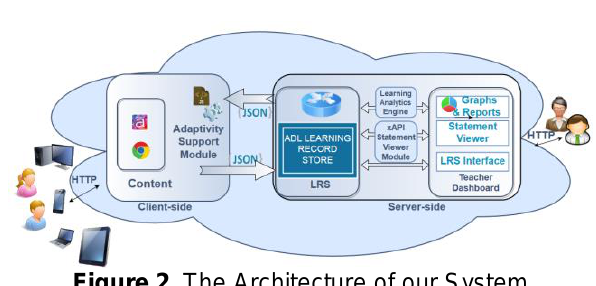
Figure 2. The Architecture of our System